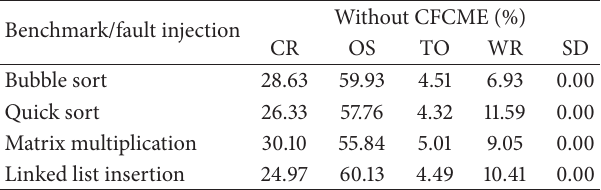
Table 4: Fault injection results on kernel components with CFCME.